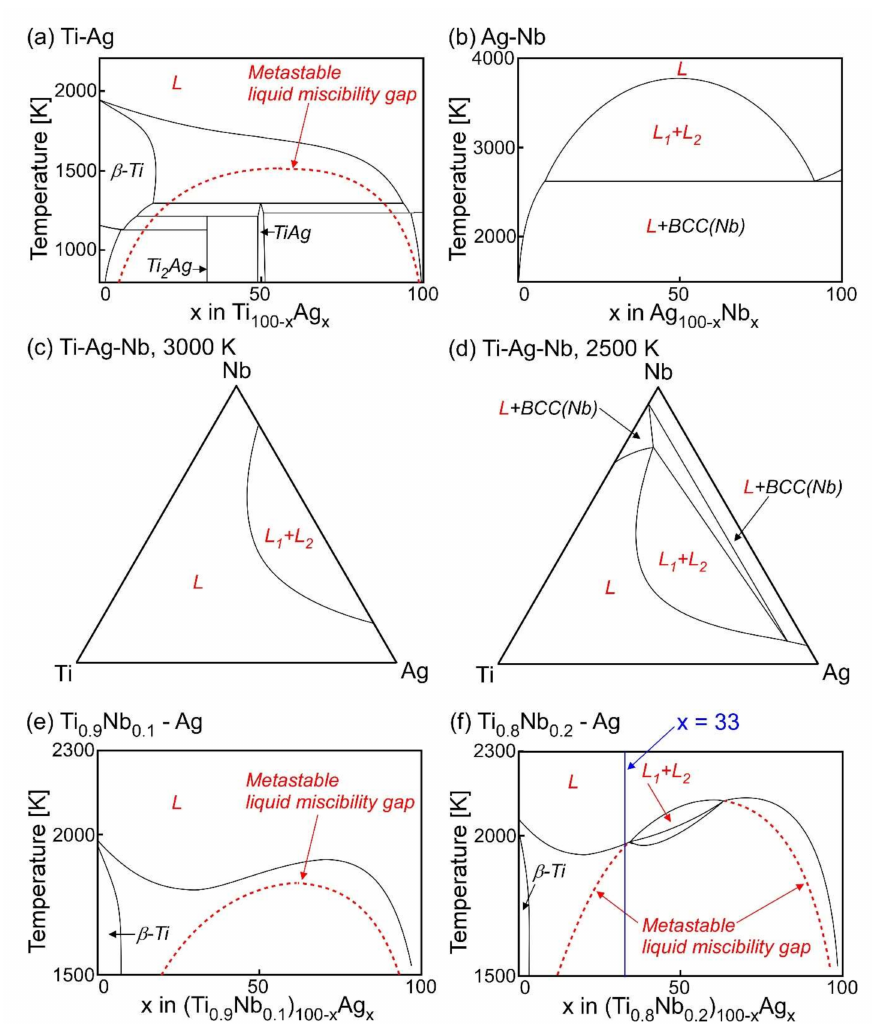
Figure 2. Thermodynamic calculation results of the Ti-Ag, Ag-Nb and Ti-Nb-Ag alloys. ( a ) Ti-Ag alloy with metastable liquid miscibility gap; ( b ) Ag-Nb alloy; ( c ) Liquidus projection in Ti-Nb-Ag alloy at 3000 K; ( d ) Liquidus projection in Ti-Nb-Ag alloy at 2500 K; ( e ) pseudo-binary Ti 0.9 Nb 0.1 -Ag alloy with metastable liquid miscibility gap; ( f ) pseudo-binary Ti 0.8 Nb 0.2 -Ag alloy with metastable liquid miscibility gap. The metastable liquid miscibility gap is represented by red broken lines. Table 1. Thermodynamic calculation results of the composition of the separated liquids in